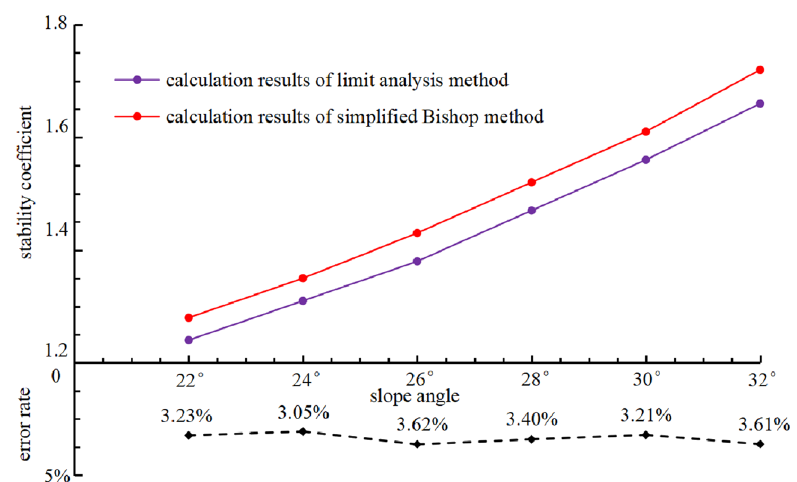
Figure 5. Calculation results of stability coefficient and error